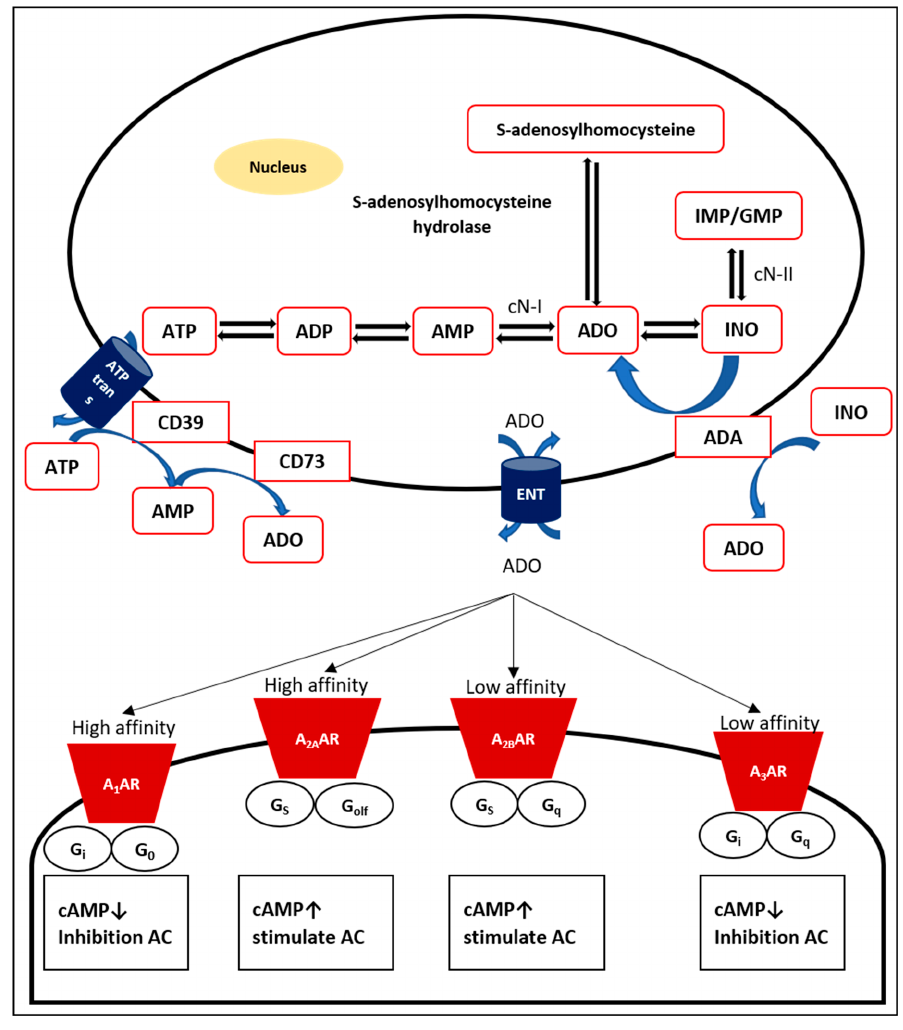
Figure 1. Production, transport and metabolism of adenosine. Intracellular adenosine is produced via dephosphorylation from the main source, AMP, via both cN I and cN-II and hydrolysis of S-adenosyl-homocysteine through the enzyme S-adenosyl-L-homocysteine hydrolase. The extracellular formation of adenosine is the result of enzymatic cascades consisting of ATP transport, hydrolysis of ATP and ADP by CD39 to form AMP, and dephosphorylation of AMP by CD73. Extracellular adenosine binds adenosine receptors (A 1 AR, A 2A AR, A 2B AR, and A 3 AR) on the surface of cells. Each AR is a GPCR that transmits the signal from adenosine by activating cAMP. ARs are members of heteromeric guanine nucleotide-binding protein (G protein)-coupled receptor (GPCR) family A [46]. All ARs have a seven-pass transmembrane α -helical structure with an extracellular amino terminus and an intracellular carboxyl terminus, and the N -terminal domain has N -glycosylation sites that influence trafficking of the receptor to the plasma membrane [22]. GPCRs, the largest class of cell surface receptors, are activated by various kinds of ligands, including hormones, neurotransmitters, ions, odorants, and photons of light, and couple to a wide range of signaling molecules and effector systems [47].